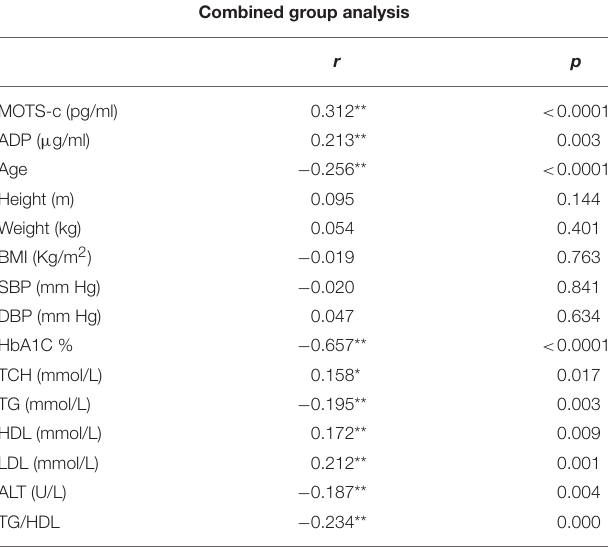
TABLE 2A | Spearman Rank correlation bivariate analysis of variables associated with